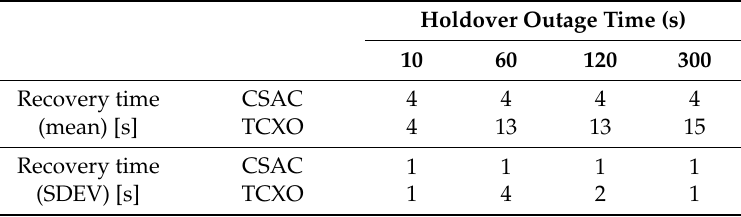
Table 7. Holdover values.